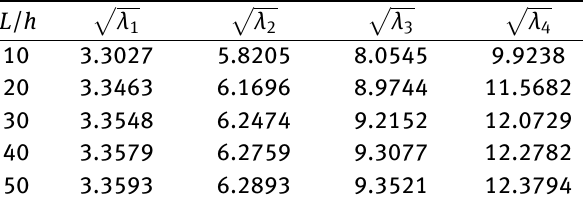
Table 20: Frequency parameter length-to-height ratio